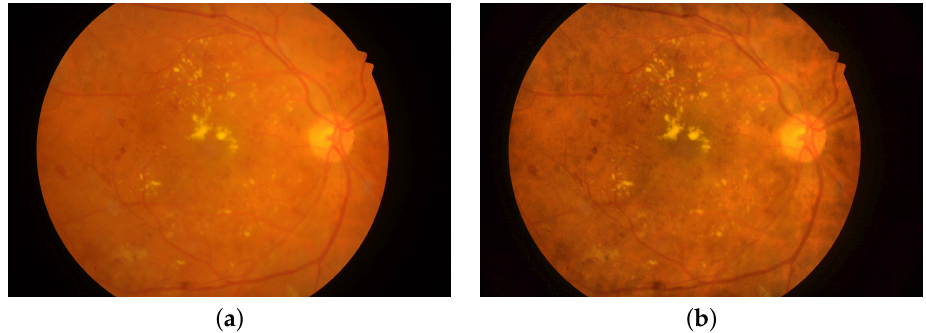
Figure 6. Colored fundus image: ( a ) original; ( b ) with contrast